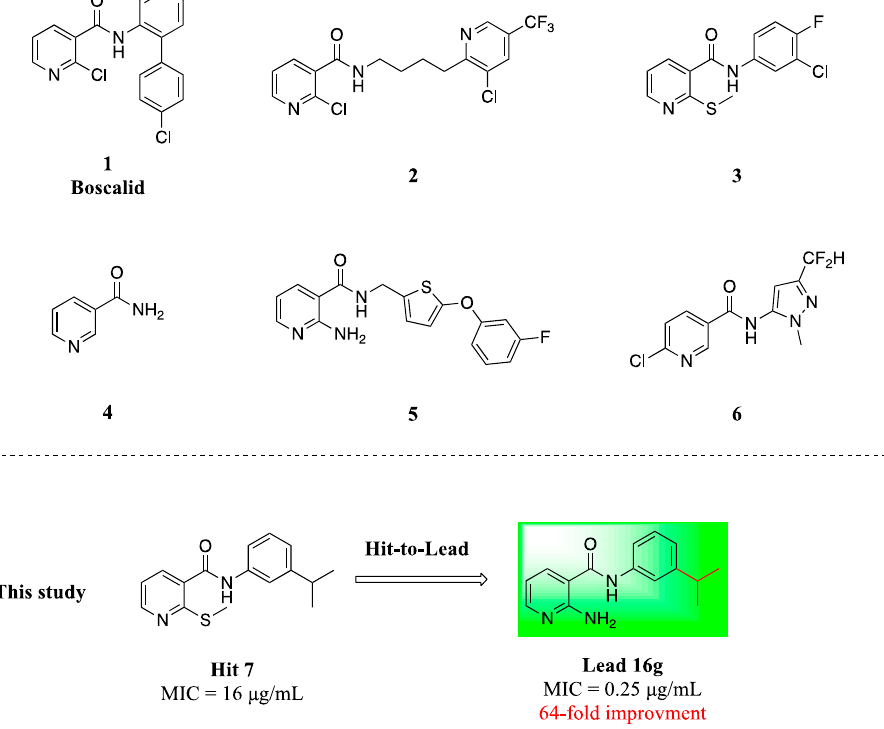
Figure 1. The structures of nicotinamide derivatives.